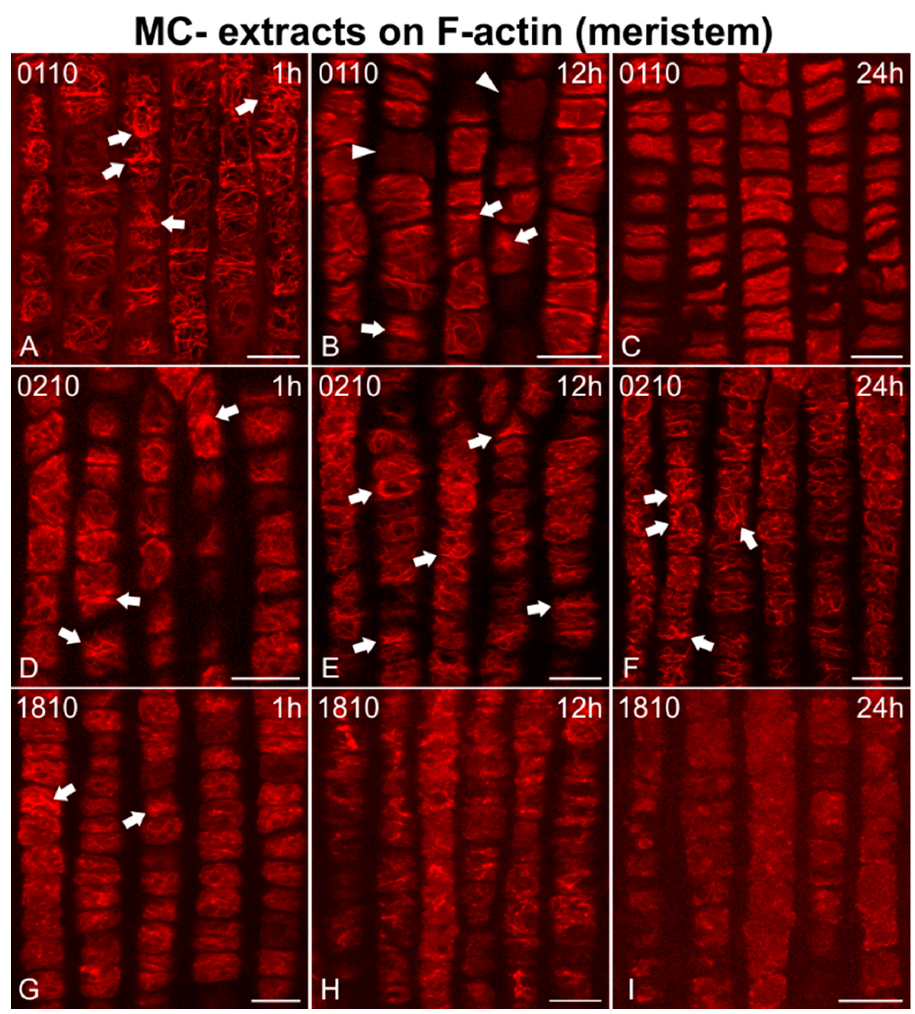
Figure 4. Single cortical CLSM sections of Oryza sativa root protodermal cells stained for F-actin, after treatment with MC − extracts, from various non-MC-producing strains: Jaaginema sp. TAU-MAC 0110 ( A – C ), Jaaginema sp. TAU-MAC 0210 ( D – F ), and Microcystis viridis TAU-MAC 1810 ( G – I ). Root